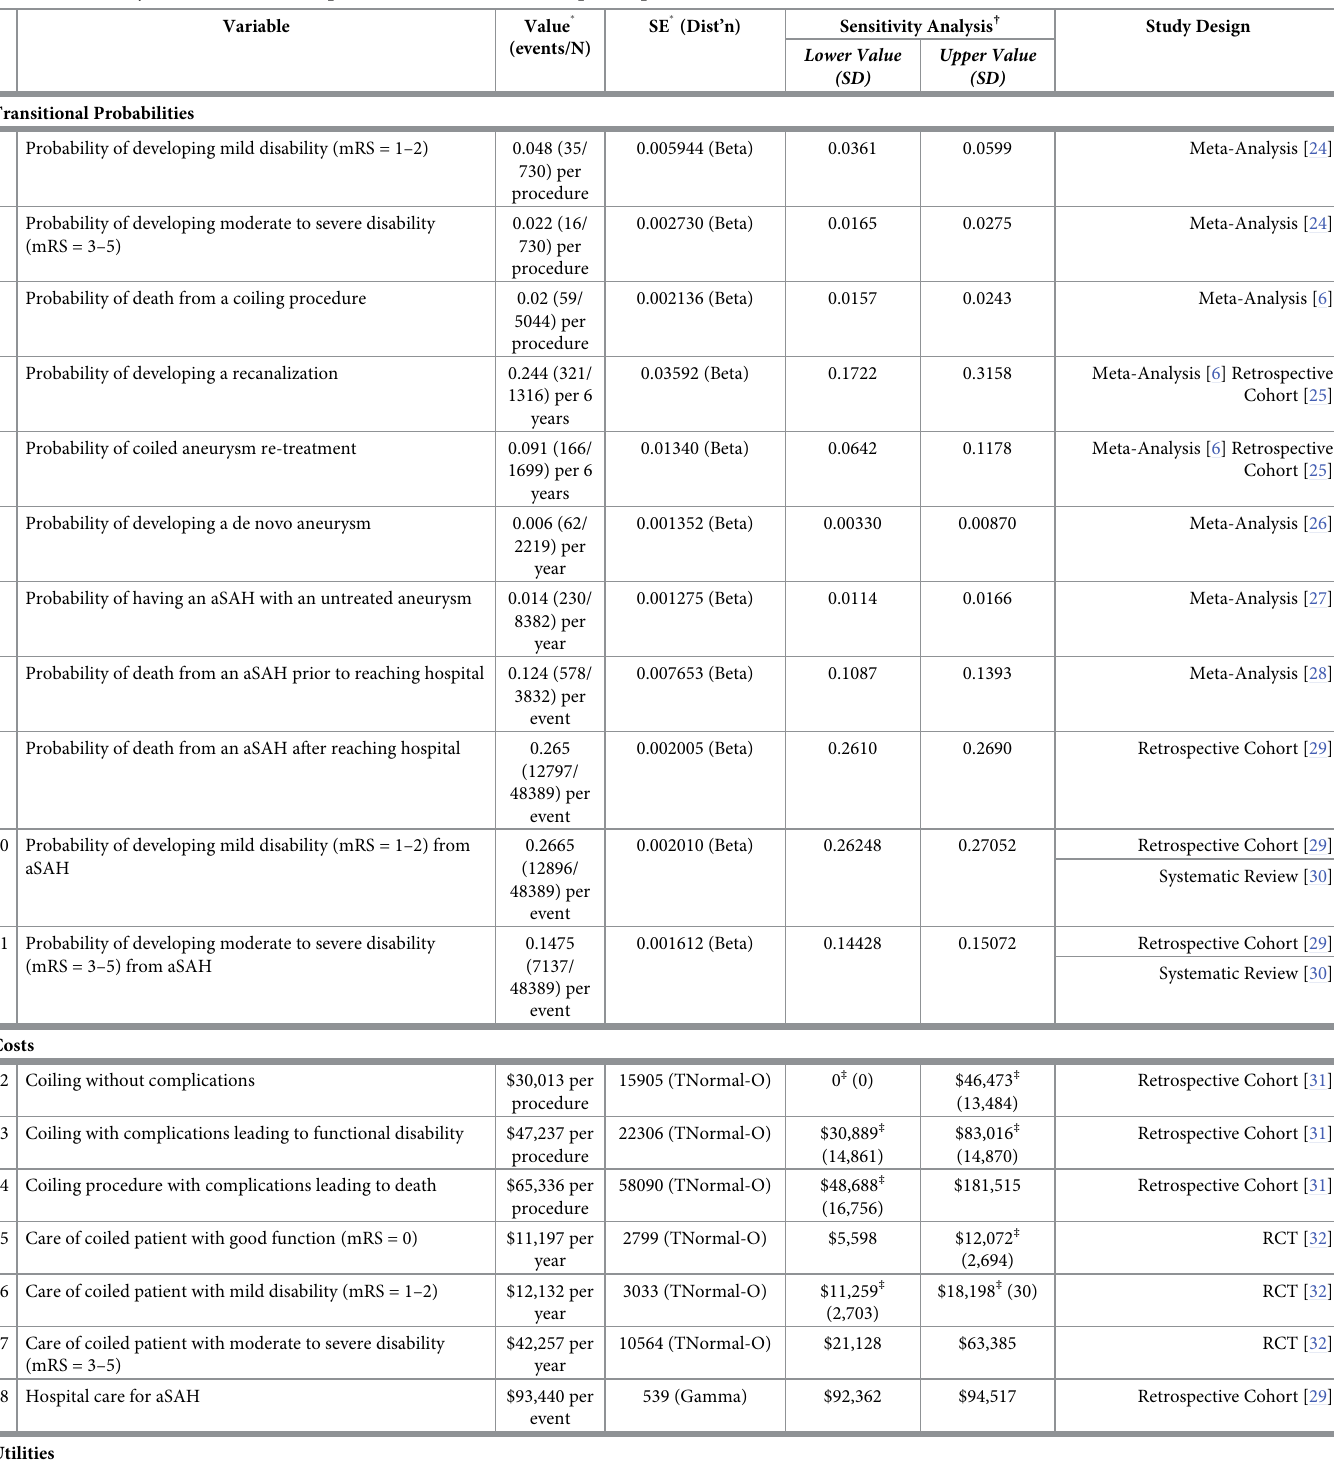
Table 1. Summary of the Markov model parameter values and their respective probabilistic